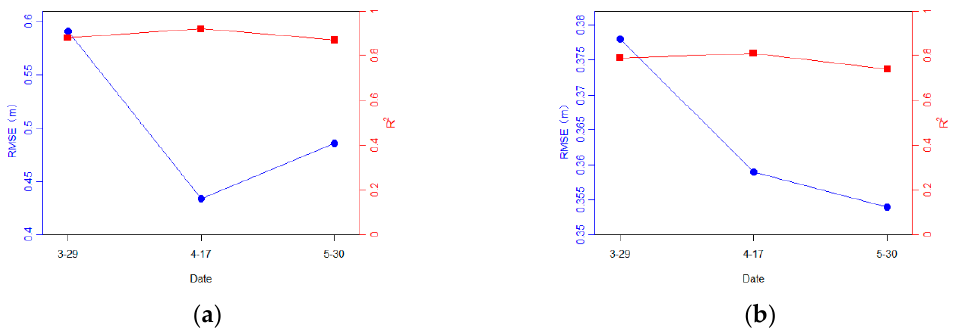
Figure 5. Box-and-whisker plot of the measured height and estimated height on the three dates for evergreen species AS ( a ) and OF ( b ). The red points indicate the tree height average; N is the sample size, which can be either the number of field-measured trees or the number of trees that were correctly detected from the photogrammetry point cloud.